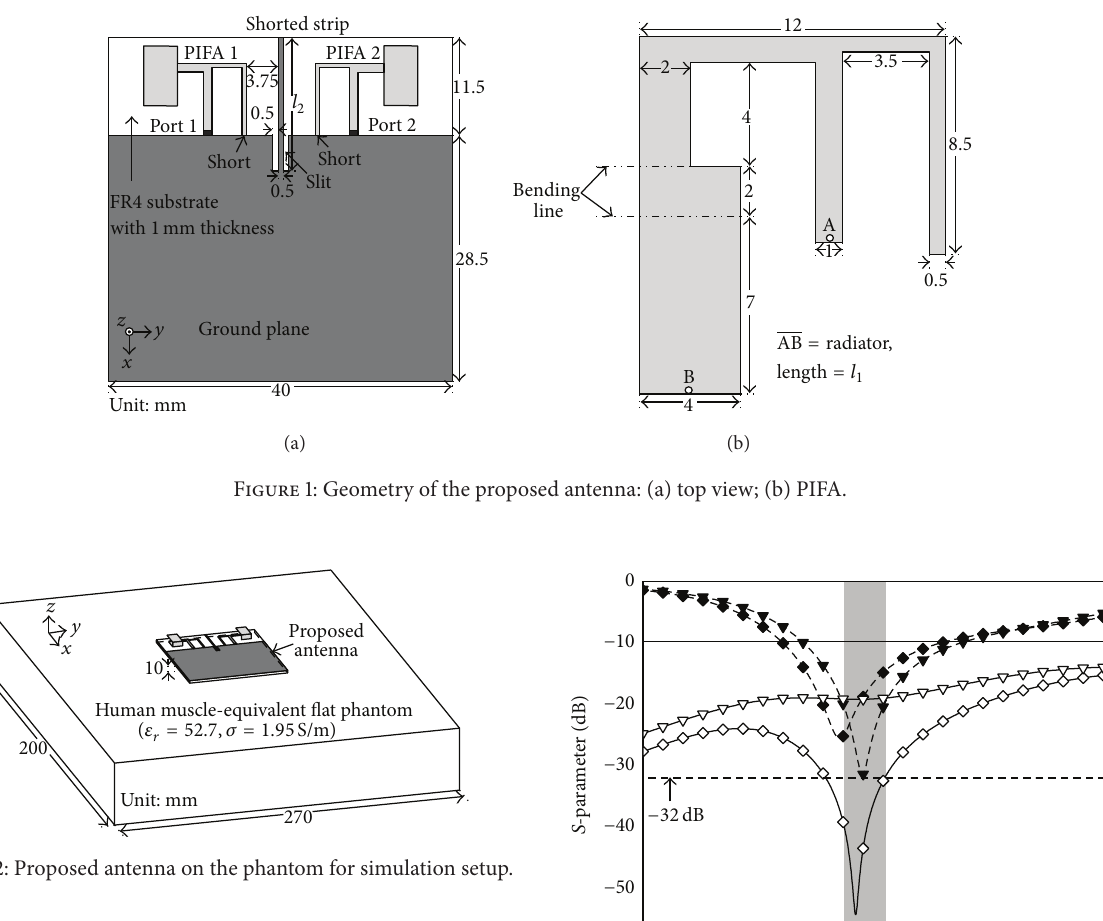
PIFAs are symmetrically placed with a separation distance of 8 mm (0.06 𝜆 ∘ ) in the 𝑦 -axis direction. The isolator and the ground plane are printed on the upper side of the substrate.